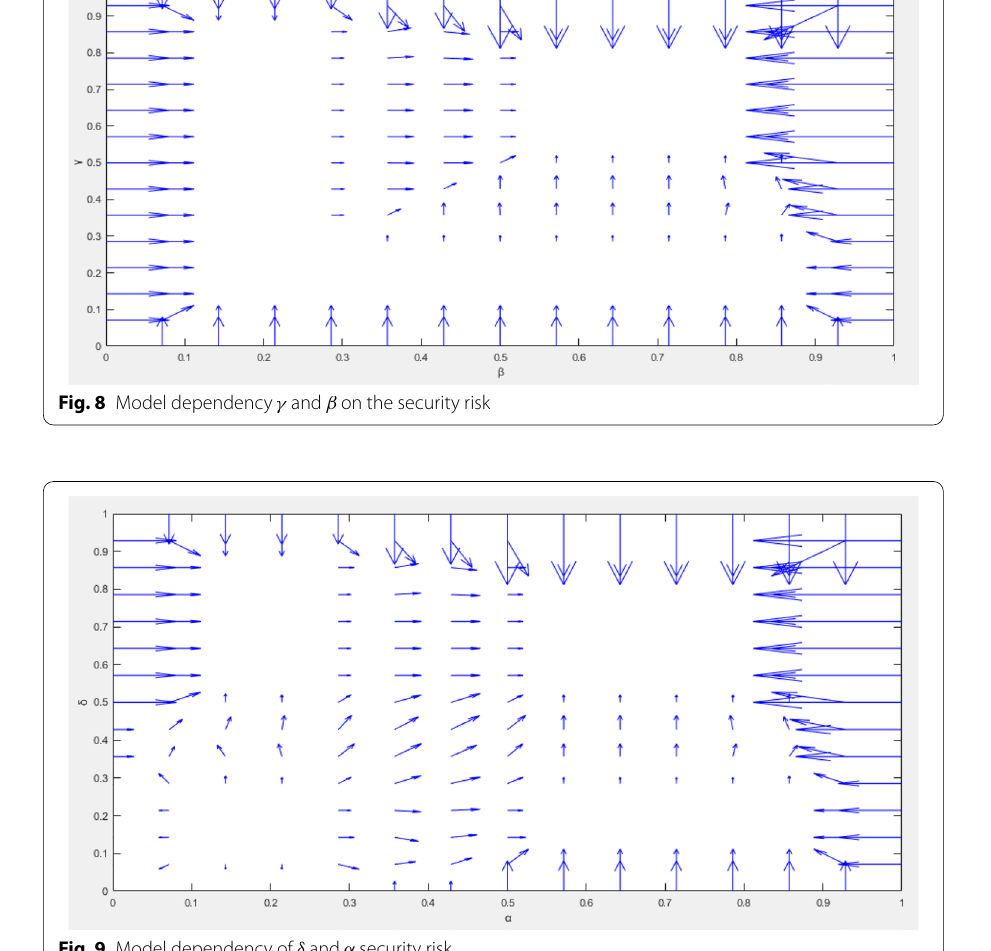
Fig. 9 Model dependency of δ and α security